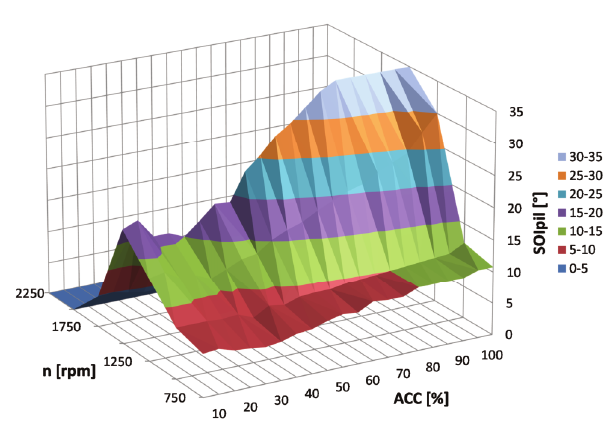
Fig. 9. Visual representation of the advance angle control algorithm for the Pilot dose